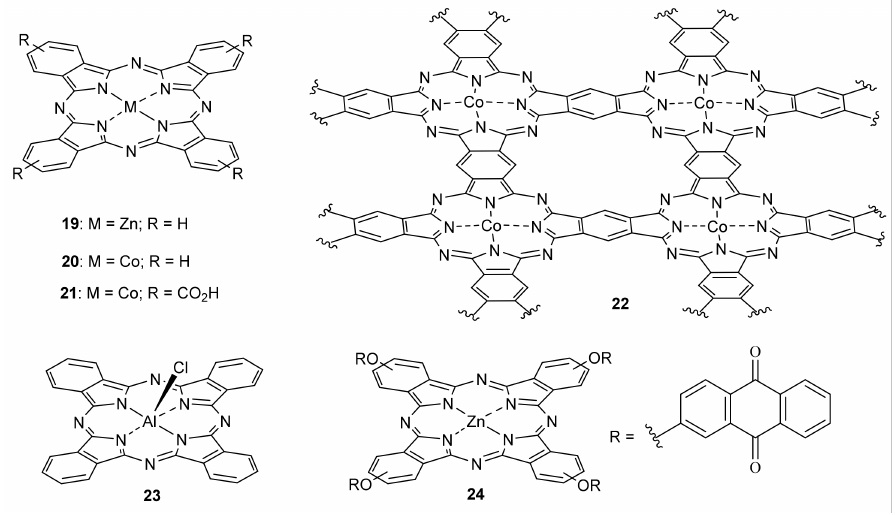
Figure 9. Pcs used in